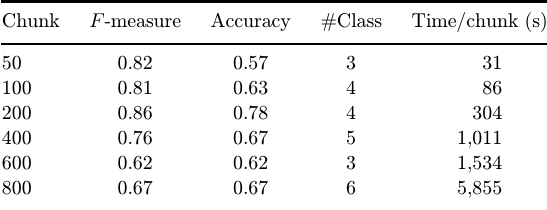
Table 4. Obtained results with di®erent chunk